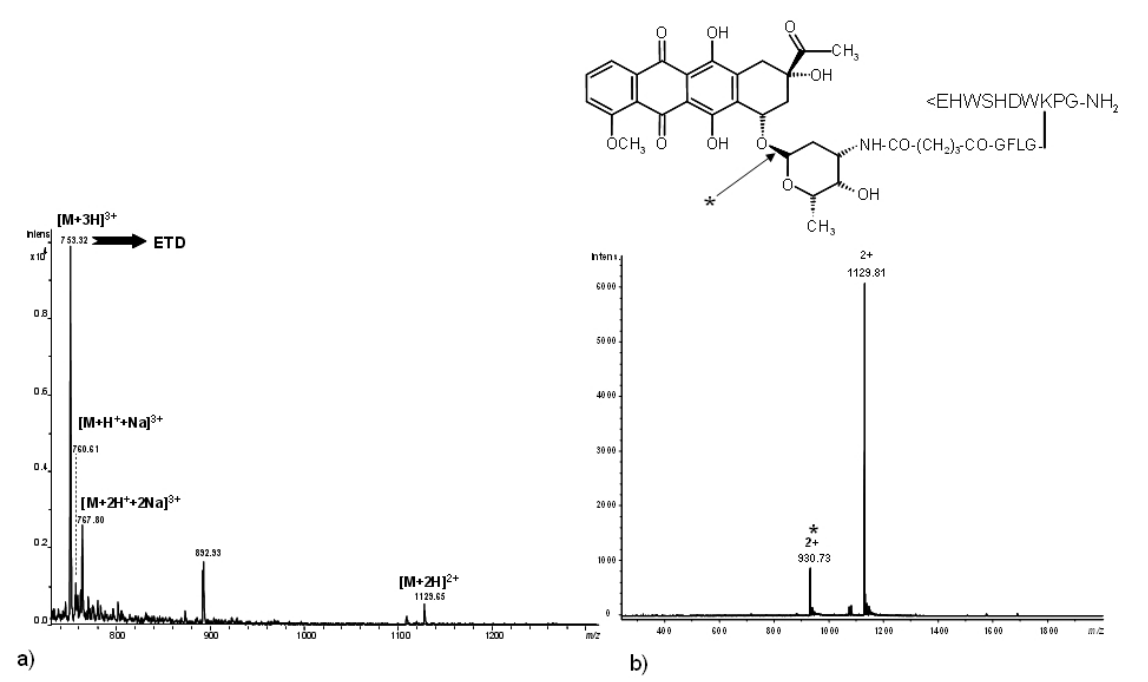
Figure 3. Comparative (+) ESI MS 1 screening of Dau-GnRH III. a) Chip based nanoESI. Concentration 0.1 pmol µL -1 in acetonitrile; b) On-line syringe pump infusion. Concentration 10 pmol µL -1 in acetonitrile.